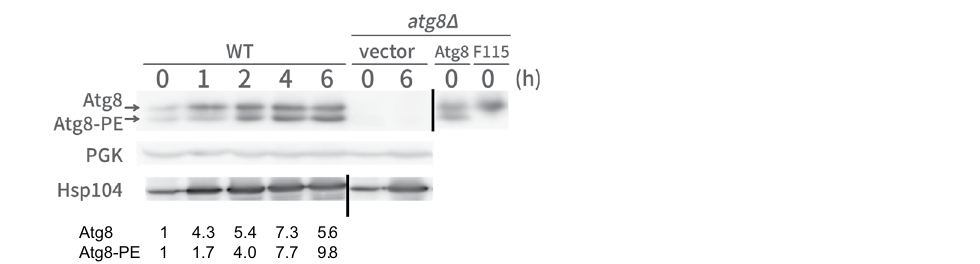
atg8 Δ and Atg8-overexpressing wild-type cells, respectively 27 . Moreover, we previously showed that LDs con- siderably increase after chronic heat stress 13 . Co-staining of LDs and vacuolar membrane with BODIPY493/503 and FM4-64, respectively, showed that some LDs but not many of the invaginations were colocalised with the invagination in atg8 Δ cells (Fig. S4a). Neither deletion of atg8 Δ nor overexpression of Atg8 significantly affected the number of LD compared with the control after 4 h at 40.5 °C (Fig. S4b). Therefore, these results suggested that LDs were not directly involved in invagination formation after chronic heat stress, which we observed in this study. However, considering the existence of LDs close to the vacuoles after chronic heat stress and the limitation of detection for very small LDs, involvement of LDs in the vacuolar invaginations is not completely deniable.